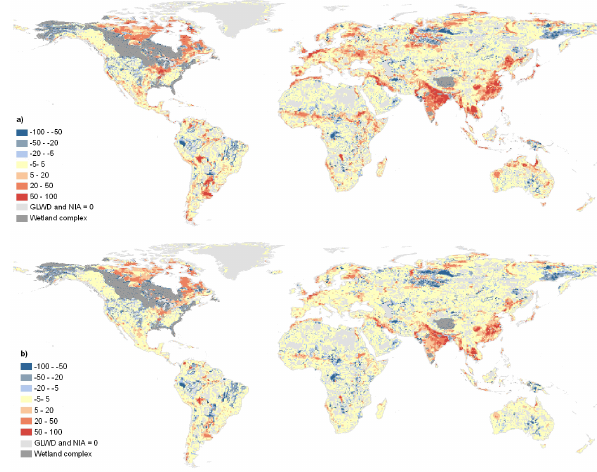
Fig. 2. Difference between the maximum value of naturally inun- dated areas (NIA) for each grid cell during 1993–2004 and the wet- land extent of GLWD, in percent of cell area (a) , and difference between the mean annual maximum of NIA and the wetland extent of GLWD, in percent of cell area (b)